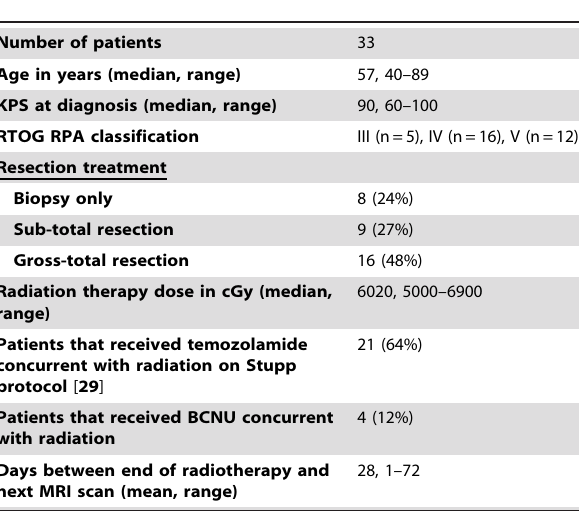
Table 1. Clinical characteristics of